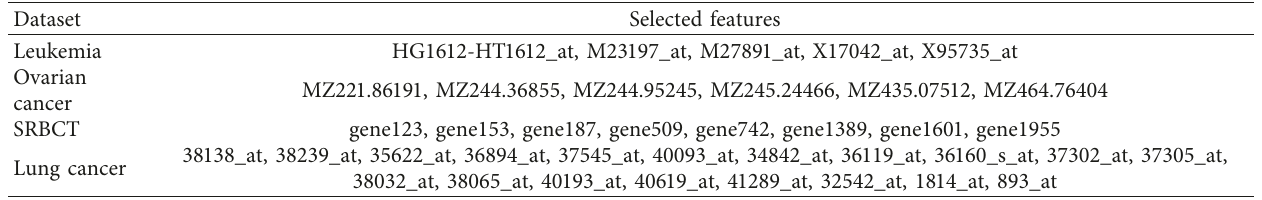
Table 9: Listing of best subset of features that achieves the best accuracy.